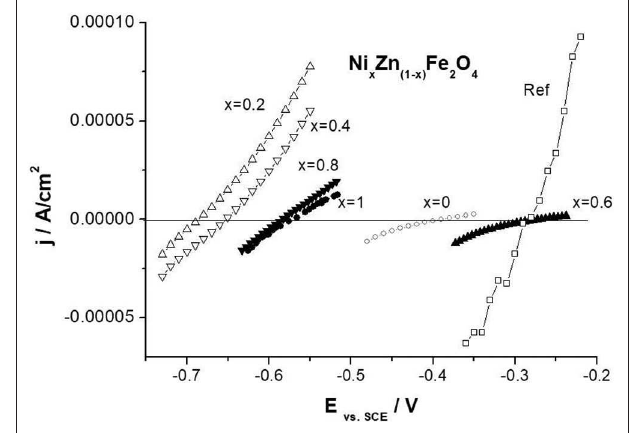
FIGURE 14 | Linear polarization plots for carbon steel in nano-ferrite and nano-Fe 2 O 3